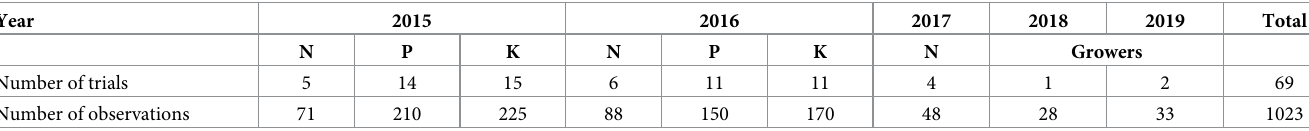
Table 1. Yearly distribution of experimental and observational data in the Brazilian garlic data